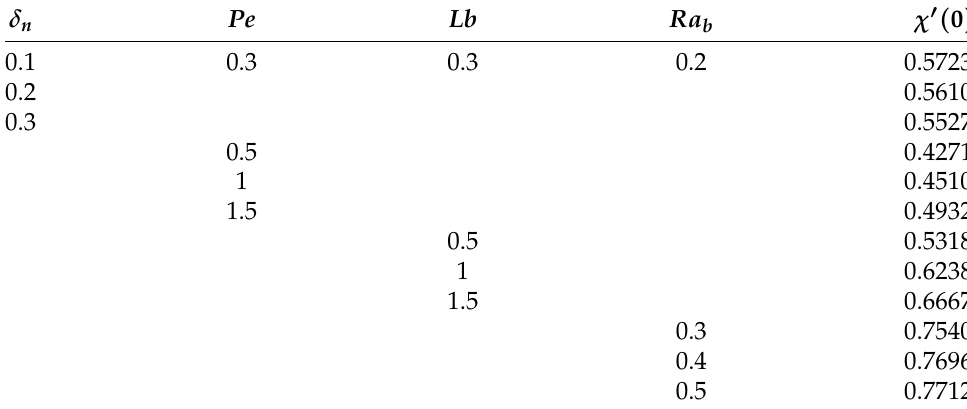
Table 5. Influence of N δ , Pe , Lb , Ra b on χ (cid:48) ( 0 )